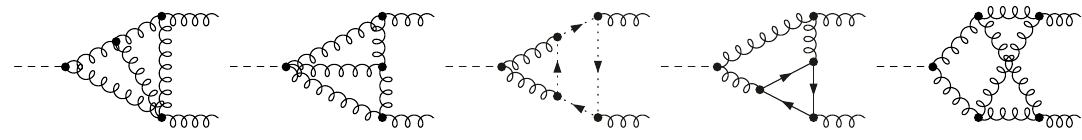
Figure 5 . Representative two-loop Feynman diagrams for the scattering amplitude H → gg . Curly, dashed, and straight lines represent, respectively, gluon, ghost, and massless fermions